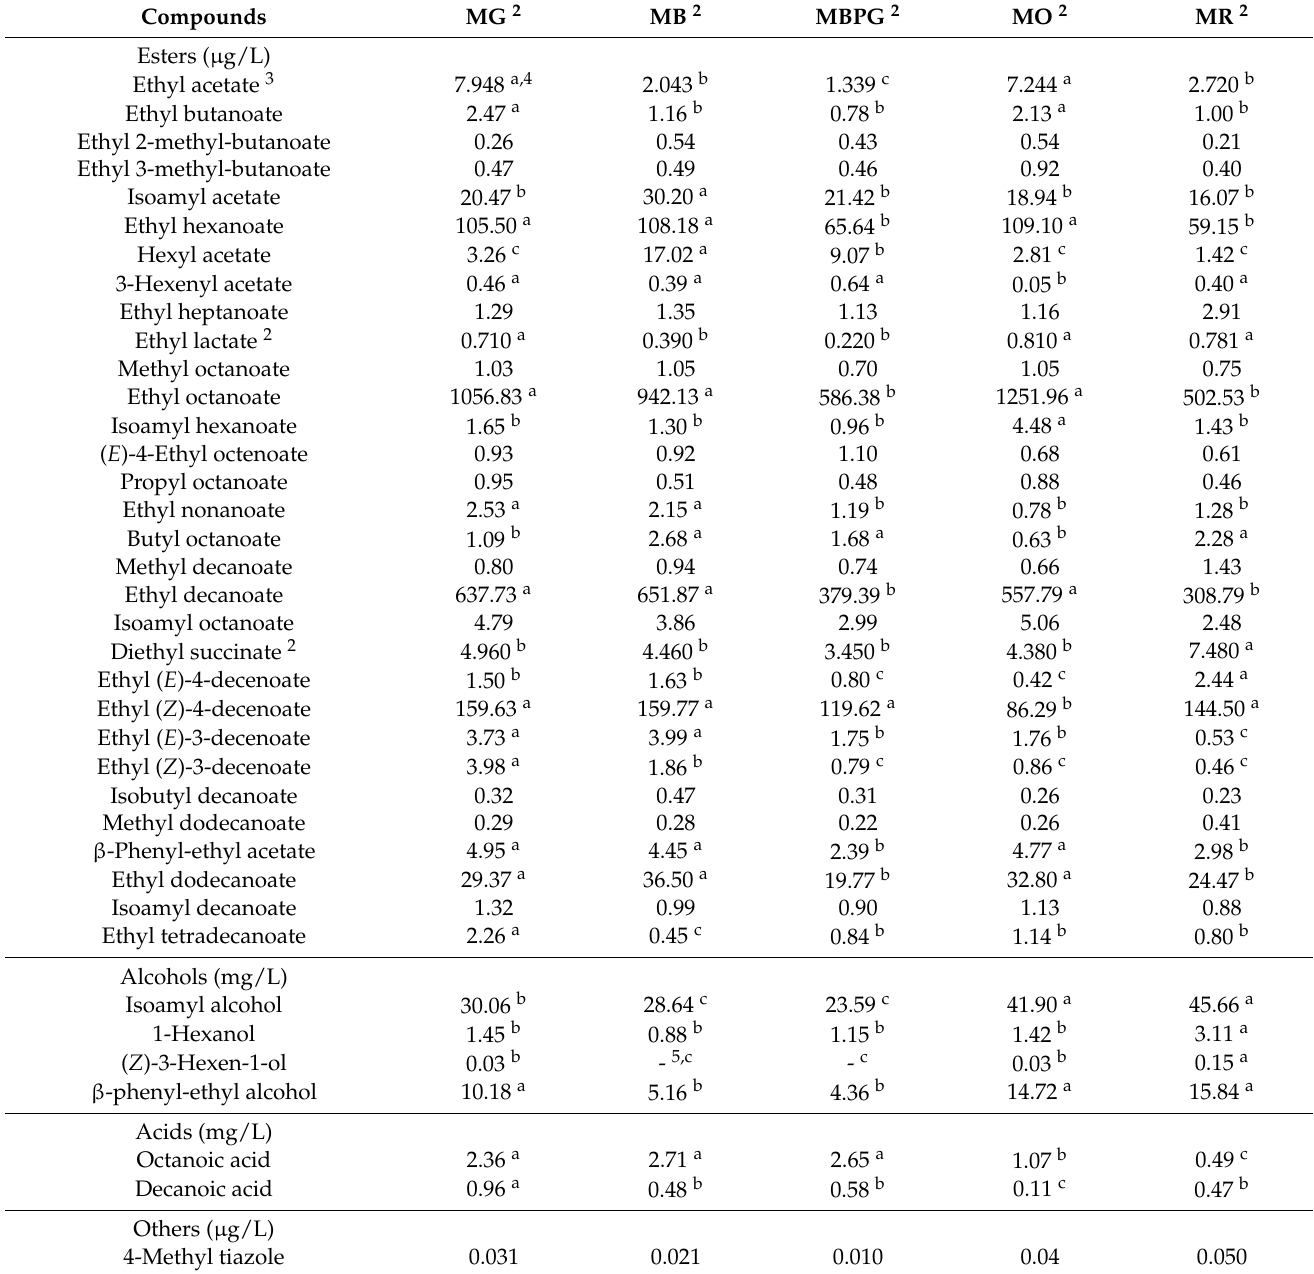
Table 2. Pre-fermentative and fermentative aroma compounds quantified (average values 1 ) in fortified wines from different Moscato